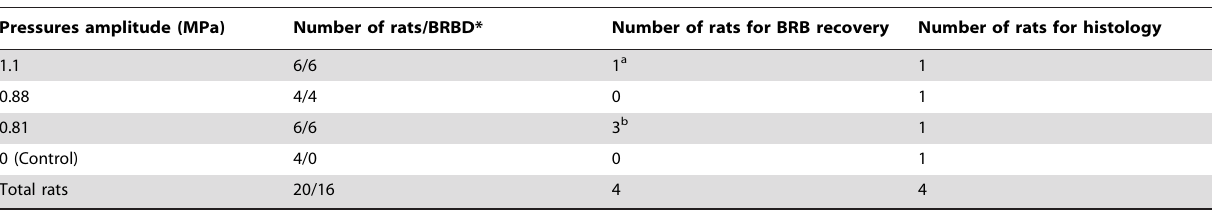
Table 1. Summary of the experimental groups.